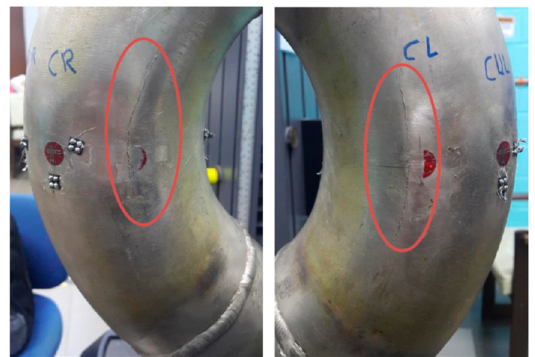
Figure 4. Fracture (crack penetration) at crown of sound elbow.